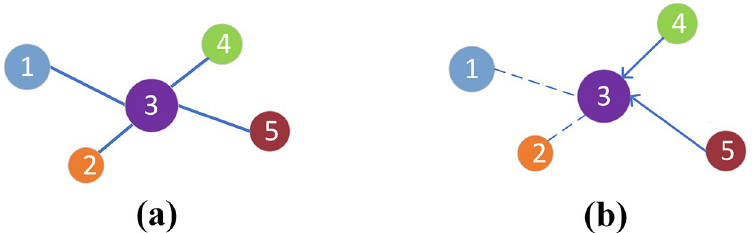
Fig 1. The sentence centrality based on the undirected graph (a) and the directed graph (b). Figure (a) shows the conventional method for computing sentence centrality, and (b) is our method. In our method, we calculate the centrality of a sentence not by calculating the similarity of the sentence to all sentences in the document but only for some specific sentences.